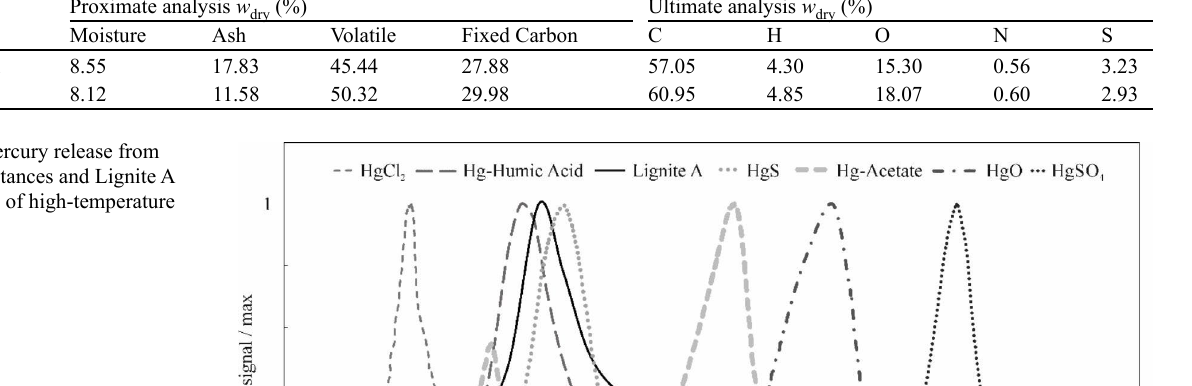
Fig. 4 Mercury release